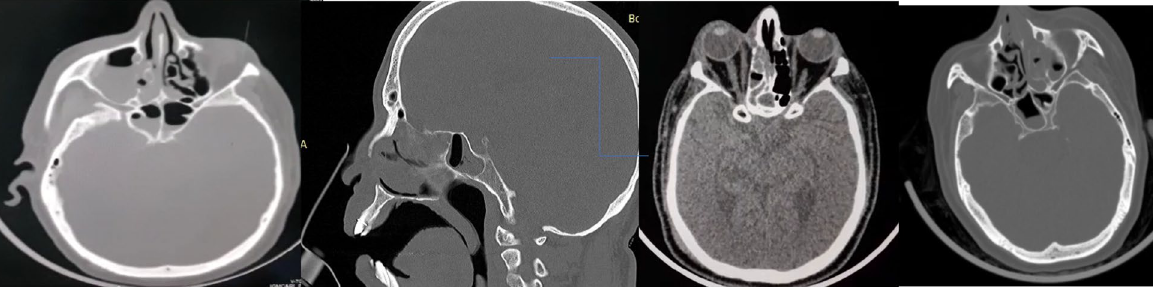
Fig. 4 CT PNS of CAM patients showing involvement of maxillary, ethmoid and sphenoid sinuses, palatal necrosis, and skull base